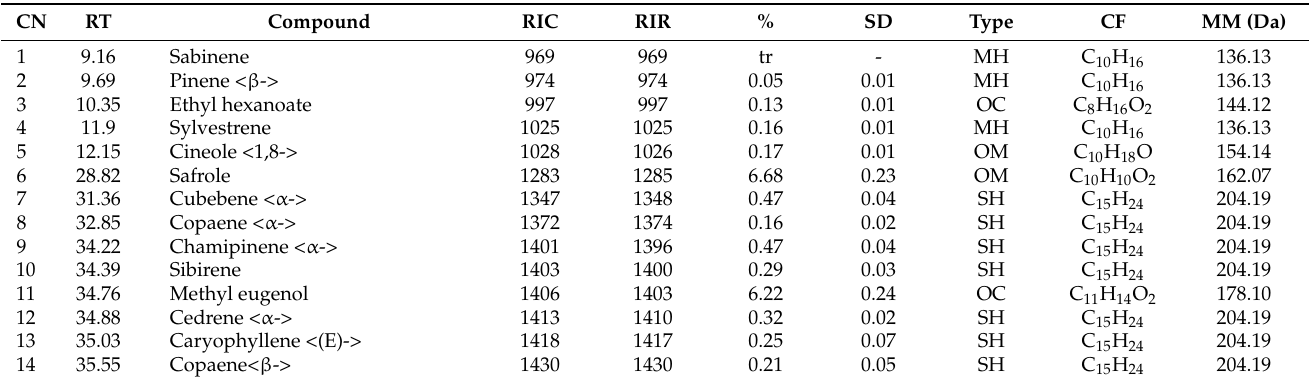
Table 2. Chemical composition of essential oil from the leaves of Peperomia inaequalifolia